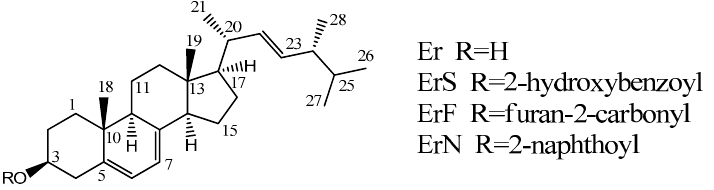
Figure 1. Structures of compounds.